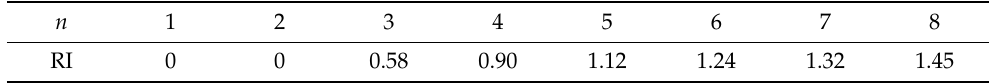
Table 2. Random consistency